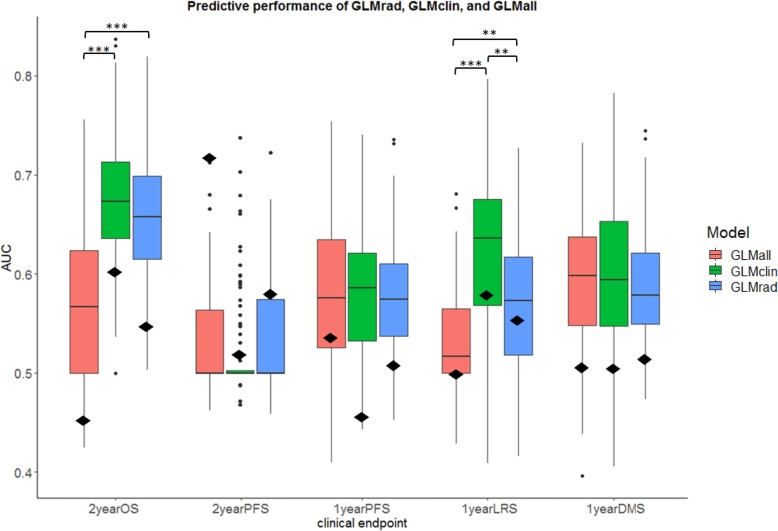
Model performance for the PET radiomics model (GLMrad), the model containing clinical variables (GLMclin), and a combination of radiomics and clinical variables (GLMall).The median AUC values from 100-times-repeated training/validation are depicted per model, per clinical endpoint. The lower and upper hinges correspond to the 25th and 75th percentiles. The whiskers depict the 1.5*IQR from the lower and upper hinge. Data beyond the end of the whiskers are shown as outlier points. AUC values corresponding to the external validation set are shown as a black diamond. Significance levels, **p<0.001, ***p<0.0001.